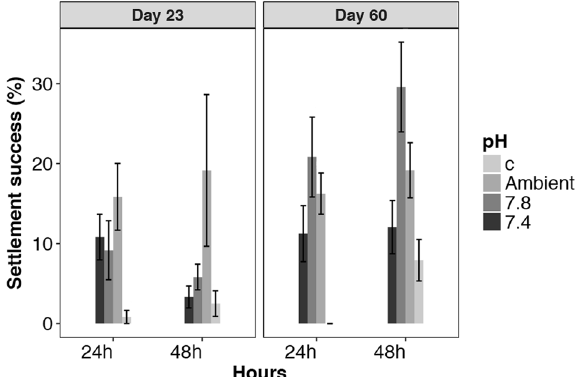
Figure 5. Settlement success of the model invertebrate (tubeworm) Galeolaria hystrix on biofilms grown at different pH. ( a ) The proportion of competent larvae settled 24 h and 48 h after being offered 23-day old biofilms developed under pH NIST 7.4, 7.8 and 8.1. ( b ) The proportion of competent larvae settled 24 h and 48 h after being offered 60-day old biofilms developed under pH NIST 7.4, 7.8 and 8.1. For each settlement experiment a control (sterile glass slide) was used to determine non-selective